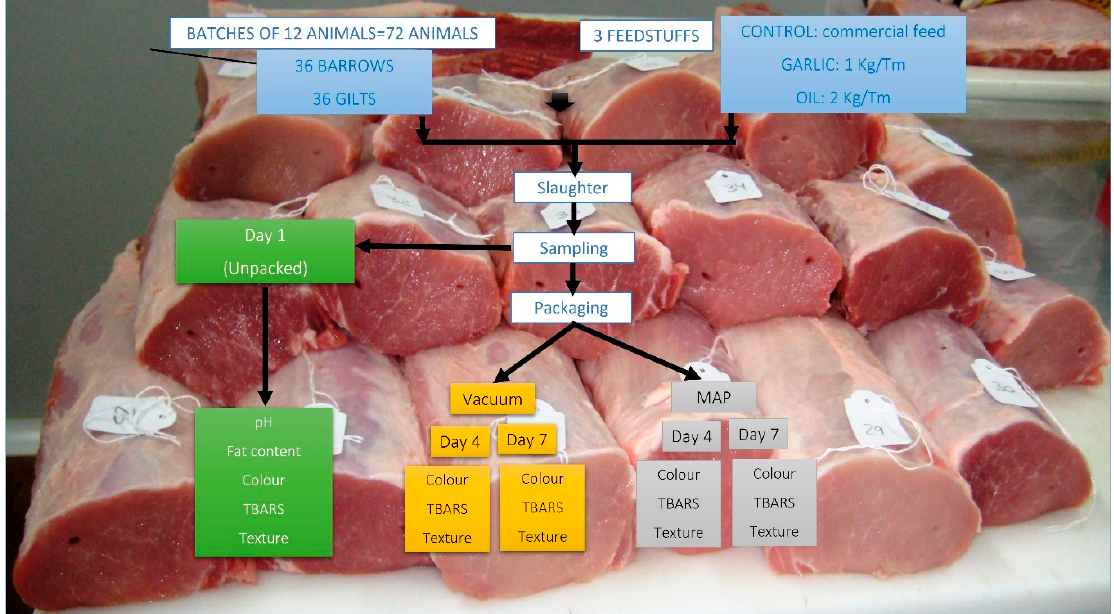
Figure 1. Experimental design. A completely randomized design was used.